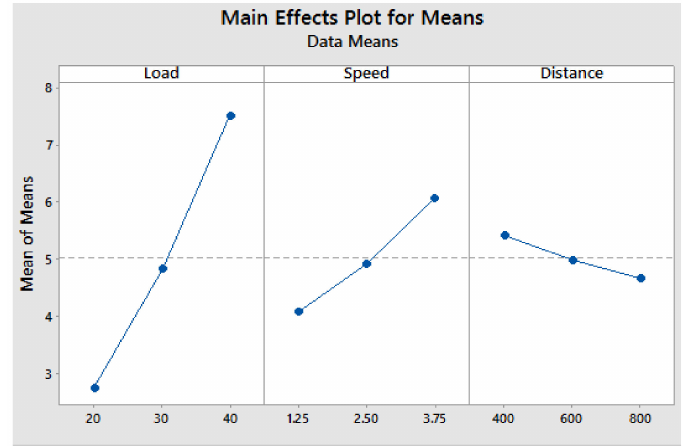
Figure 12. Mean effect plot for sample A1.